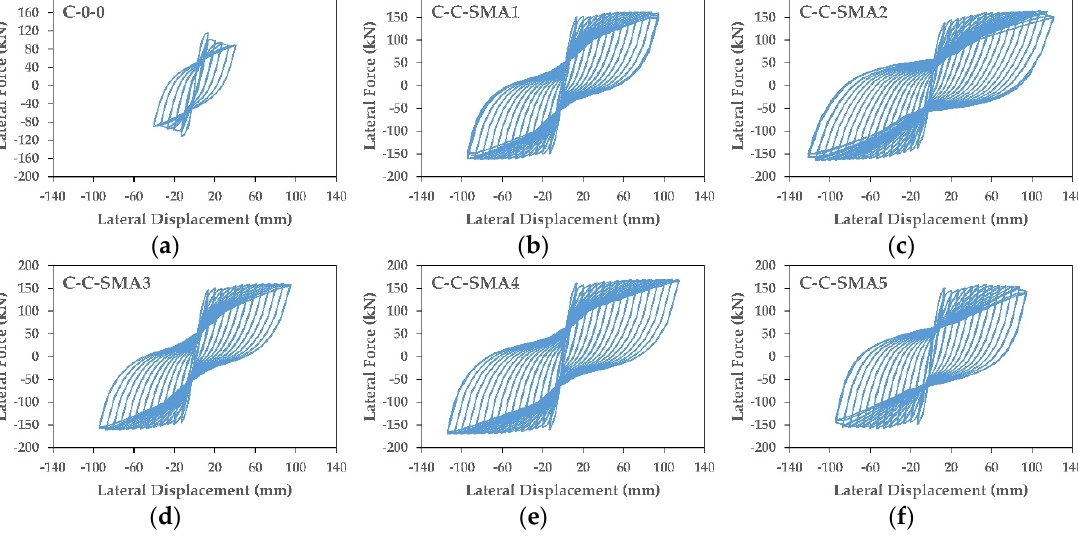
Figure 12. ( a – f ) Force displacement relationship of the columns in Group1.